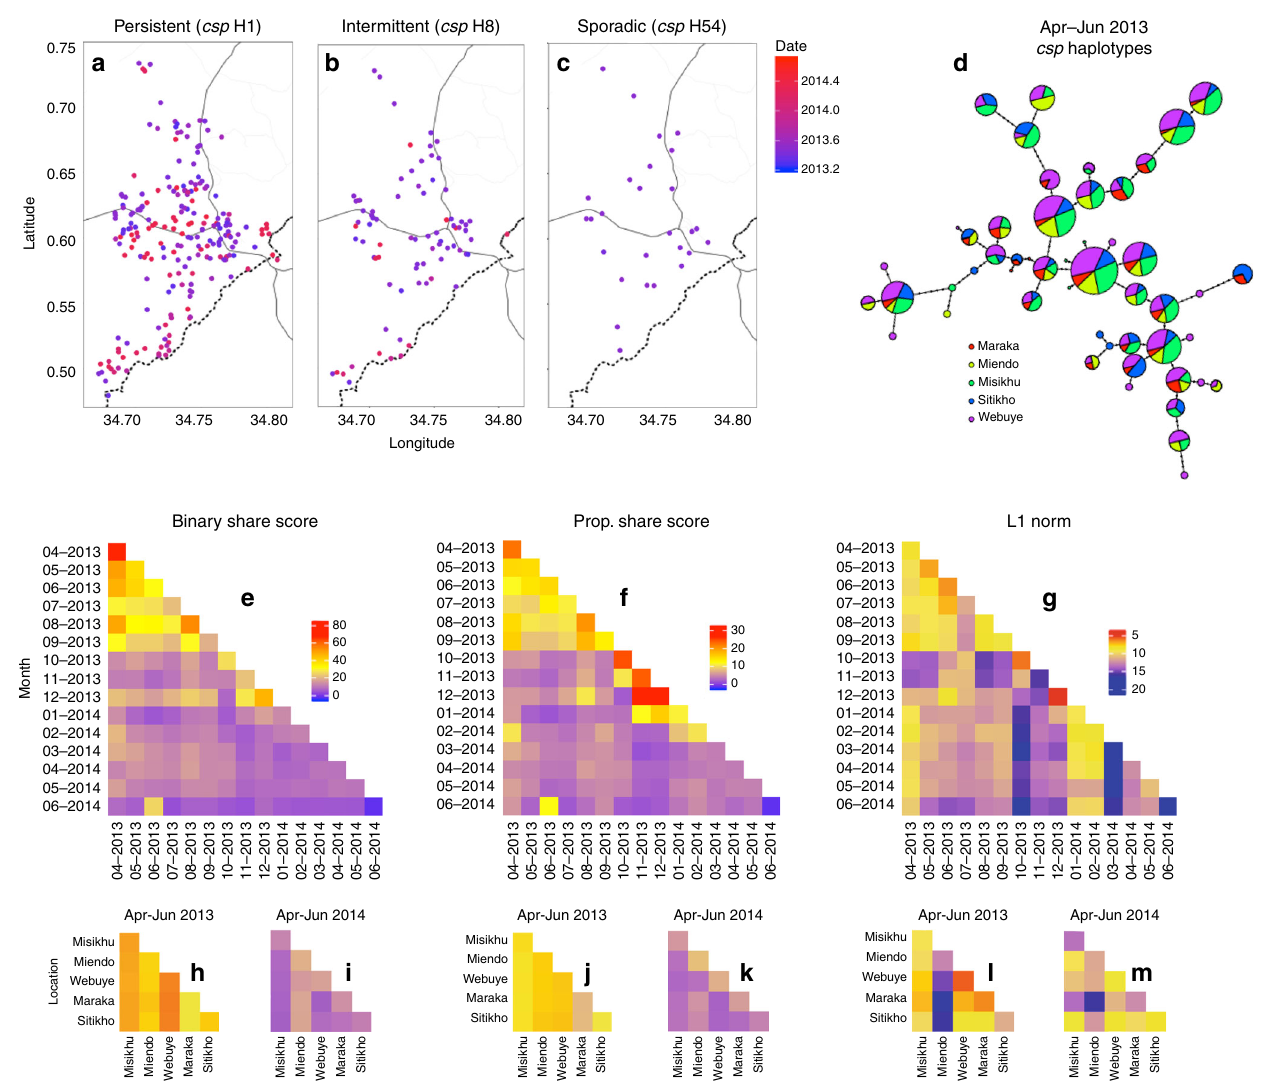
Fig. 3 Genetic similarity of csp haplotypes is structured by time more than space. a – c Location of study participants with ‘ persistent ’ haplotype csp H1 ( a ), ‘ intermittent ’ haplotype csp H8 ( b ), and ‘ sporadic ’ haplotype csp H54 ( c ). Blue color indicates the beginning (April 2013) and red the end (June 2014) of the study period, with the date denoting fractional years in decimal notation. d csp haplotype network for the high transmission season of April through June 2013 (for fi ve most represented administrative locations: Maraka, Miendo, Misikhu, Sitikho, and Webuye). Each circle indicates a unique haplotype with size proportional to the log 2 -scaled haplotype prevalence and color denoting the fractional prevalence in each administrative location. Haplotype connections were calculated using an in fi nite site model (Hamming distance) of DNA sequences, with dots along connections indicating the number of base-pair differences between sequences. e – g Temporal comparison heat maps of mean binary haplotype sharing ( e ), proportional haplotype sharing ( f ), and L1 norm genetic distance ( g ) calculated between months of study enrollment. h – m Spatial comparison heat maps of binary haplotype sharing ( h , i ), proportional haplotype sharing ( j , k ), and L1 norm genetic distance ( l , m ) calculated for a distinct temporal window ( h , j , l : April-June 2013; i , k , m : April – June 2014) for the fi ve most represented administrative locations (see above), which are arranged from north to south (see map in Fig.